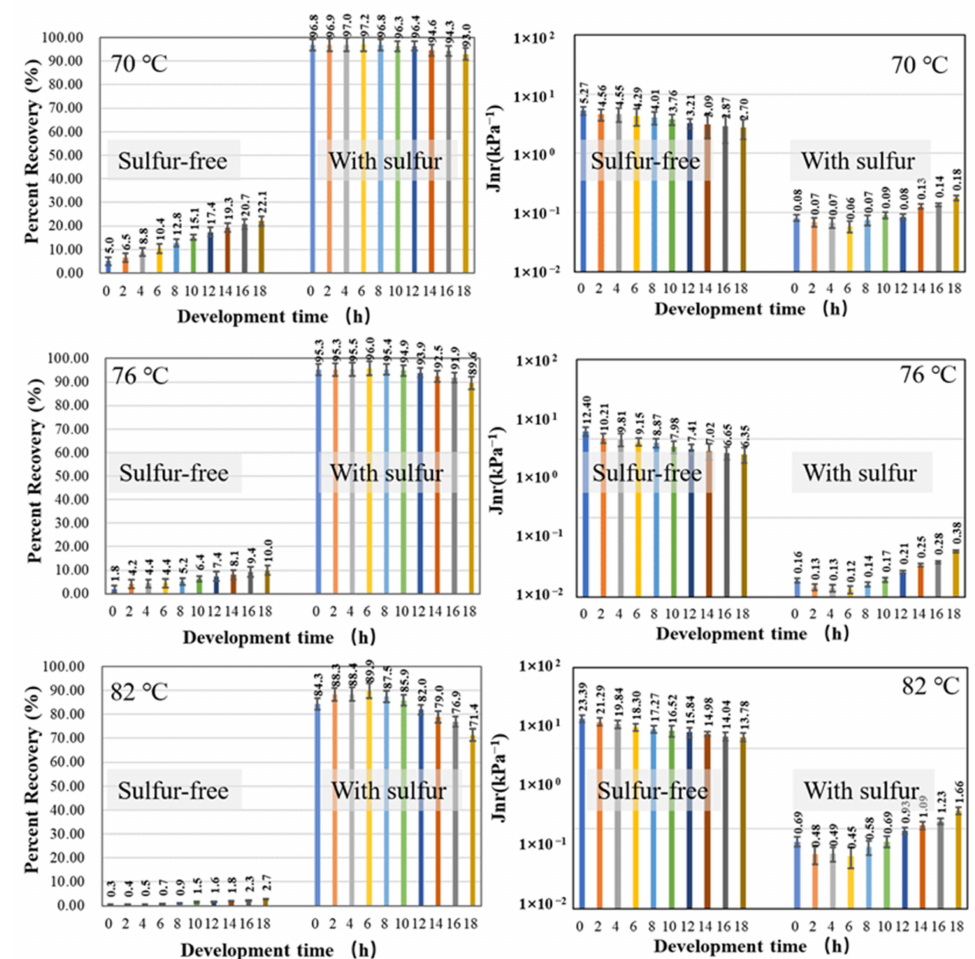
Figure 10. Comparison of MSCR test results of SBS-modified asphalt with or without